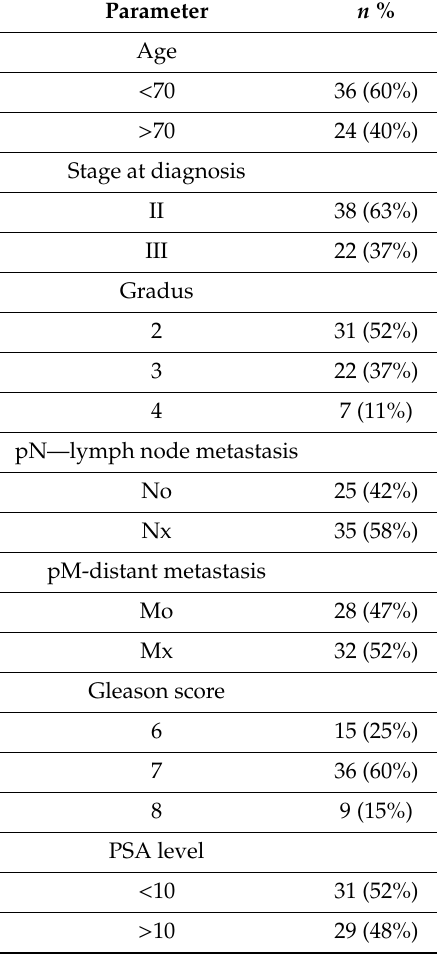
Table 1. Characteristics of the study